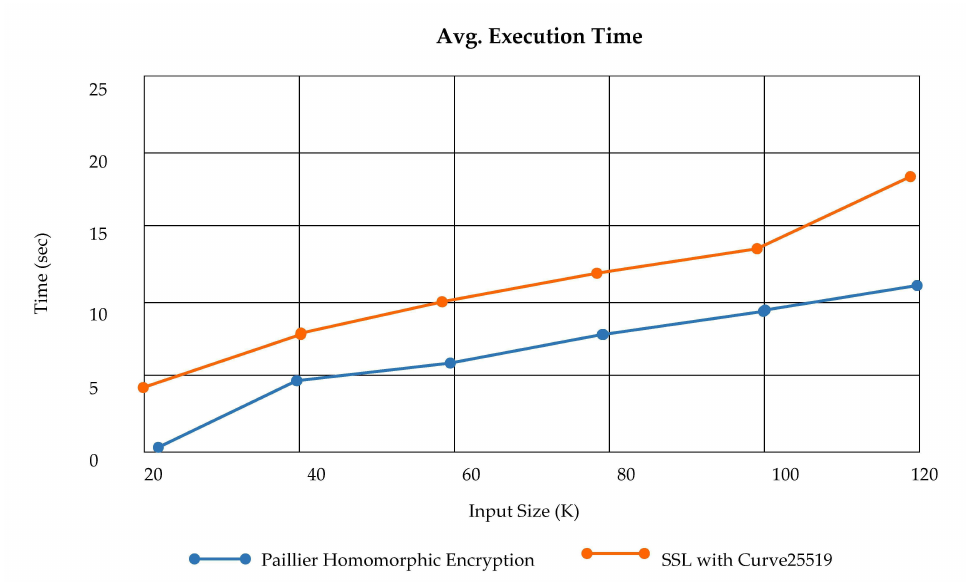
Figure 20. Secure log storage processing session establishment analyses.